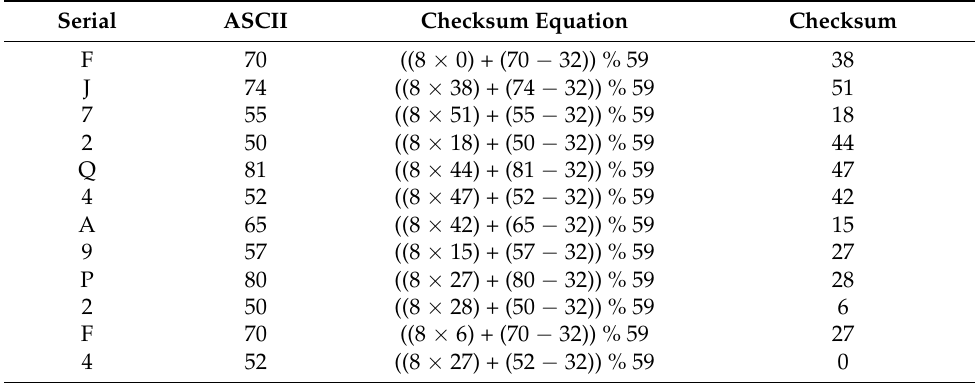
Table 3. Checksum calculation of the serial number